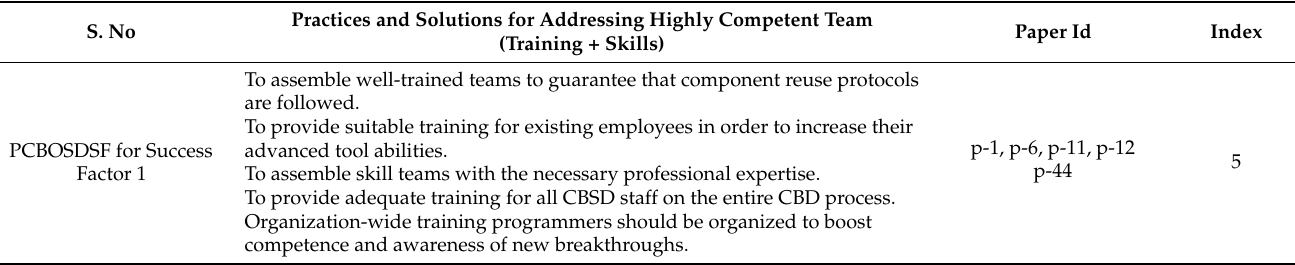
Table 5. CBOSDSF 1: Highly competent team (training + skills).